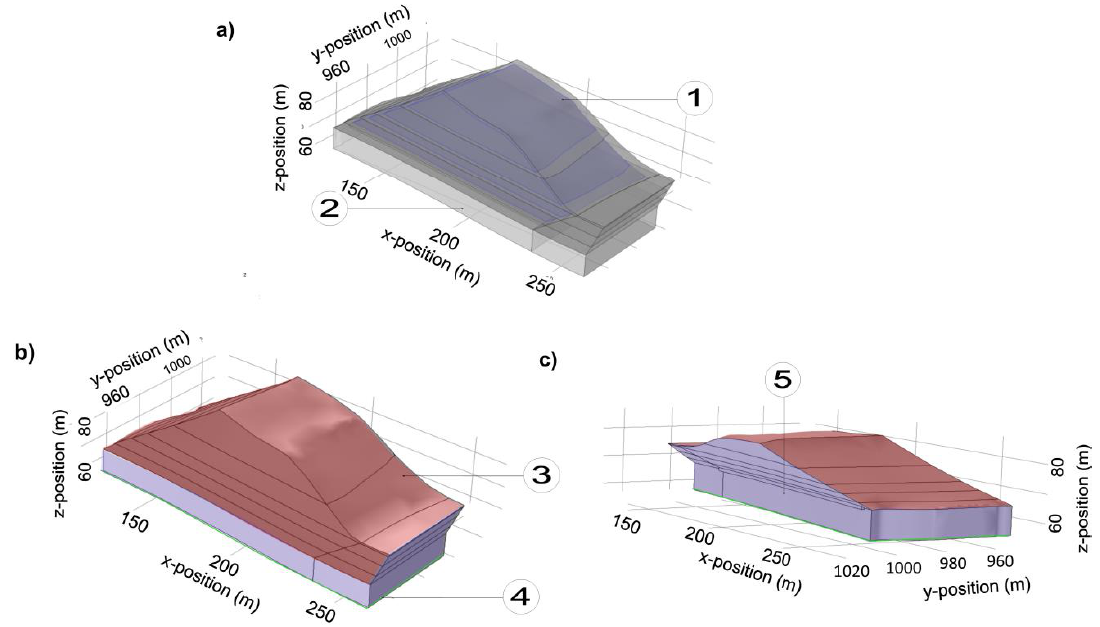
Figure 4. Geometry and boundary conditions of waste deposit CELL4: ( a ) distribution of the material properties ( ① waste; ② loam soil), ( b , c ) boundary conditions ( ③ air temperature in red; ④ average soil temperature in green; ⑤ symmetry boundary in purple).